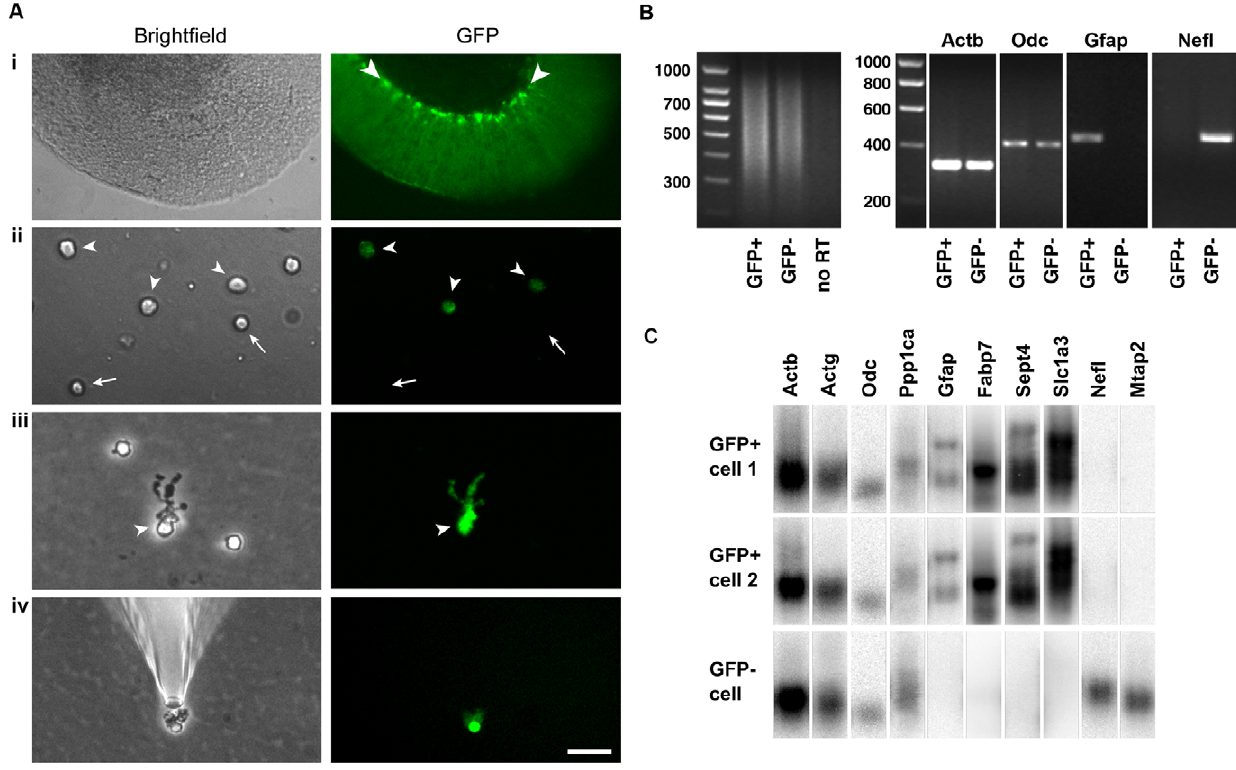
Figure 1. Harvesting of individual Bergmann glia and quality control of single-cell cDNA. Ai , a live cerebellar slice obtained from an adult GFAP-GFP transgenic mouse imaged under phase contrast optics (left) and fluorescence illumination (right). The Bergmann glia (see arrowheads) are the cells with the most fluorescence. Aii , freshly dissociated cells include putative astrocytes, which are devoid of processes and show relatively weak GFP fluorescence (arrowheads), and putative granule neurons, which have small, round, GFP-negative cell bodies (arrows). Aiii , a freshly dissociated Bergmann glia (arrowhead in left panel) can be distinguished from other cells by the bushy processes that emanate from one side of the soma–these are the long Bergmann glial processes that have partially retracted or been sheared off during tissue dissociation. In addition, Bergmann glia display strong GFP fluorescence (arrowhead in right panel), with the mean GFP intensity of their cell bodies 2.9 6 0.8 fold that of astrocytes; n=17 cells). Aiv , a single Bergmann glia being washed by placement in a new dish containing fresh buffer, before being picked again with a new microelectrode. This step is performed to exclude contaminating cells or mRNAs. Scale bar, 70 m m in Ai , 25 m m in Aii and Aiii , 40 m m in Aiv . B , left panel, agarose gel electrophoresis of cDNAs generated from single GFP + and GFP 2 cells. The gels show that most of the cDNA lies between 300 and 1000 bases. Right panel, agarose gels showing PCR with primer pairs directed towards b -actin ( Actb ), ornithine decarboxylase ( Odc ), Gfap , and neurofilament light chain ( Nefl ). The results show that the single cell cDNAs from Bergmann glia (GFP + ) and neurons (GFP 2 ) contain both high and low abundance transcripts ( Actb and Odc , respectively). Bergmann glia are positive for the astroglial marker Gfap and negative for the neuronal marker Nefl , whereas neurons are negative for Gfap and positive for Nefl . C . Southern blot analysis of cDNAs from two putative Bergmann glial cells (GFP + ) and a putative neuron (GFP 2 ) shows presence of the high, medium, and two low abundance markers ( Actb , Actg , and Odc and Ppp1ca , respectively). In addition, the GFP + cells are positive for Gfap , Fabp7 (BLBP), Sept4 and Slc1a3 (GLAST), confirming their glial identity, whereas the GFP 2 cell lacks all these markers. Conversely, the GFP + cells are absent for the neuronal markers Nefl and Mtap2 whereas the GFP 2 cell is positive. These results confirm the preservation of low to high abundance transcripts after the single-cell RT-PCR amplification, and also confirm the cell identity of the Bergmann glia used for microarray analysis.